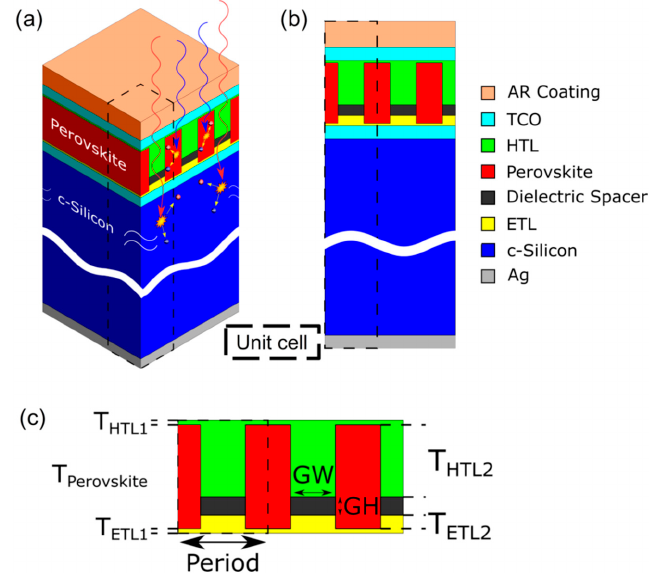
Figure 1. 3D ( a ) and 2D ( b ) schemes of the proposed nanostructured configuration of a monolithic perovskite-silicon tandem solar cell. The considered structure allows a guiding effect of photons of high wavelengths (red lines in Figure 1a) towards the silicon layers, while short wavelengths (blue lines) generate electron-hole pairs in the perovskite layer. The detail of the layers and the considered unit cell (dashed boxes) of our simulations are also included. ( c ) Detail of the nanostructure with the definition of the corresponding geometrical parameters.